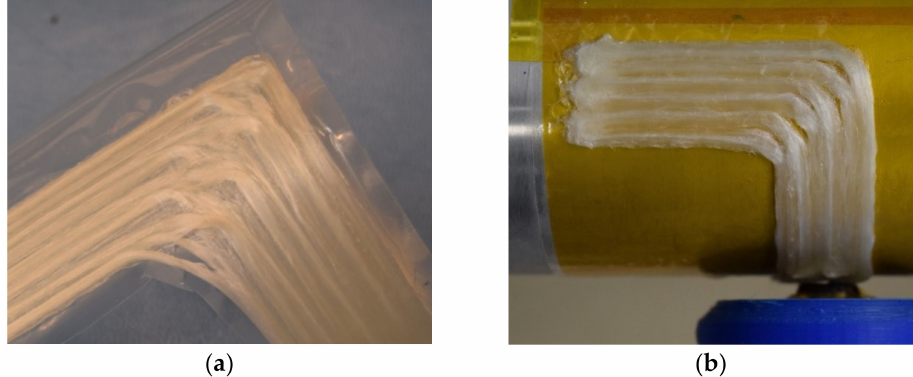
Figure 6. An L bracket produced ( a ) without local air cooling and ( b ) with local air cooling, demon- strating the effectiveness of the cooling manifold.